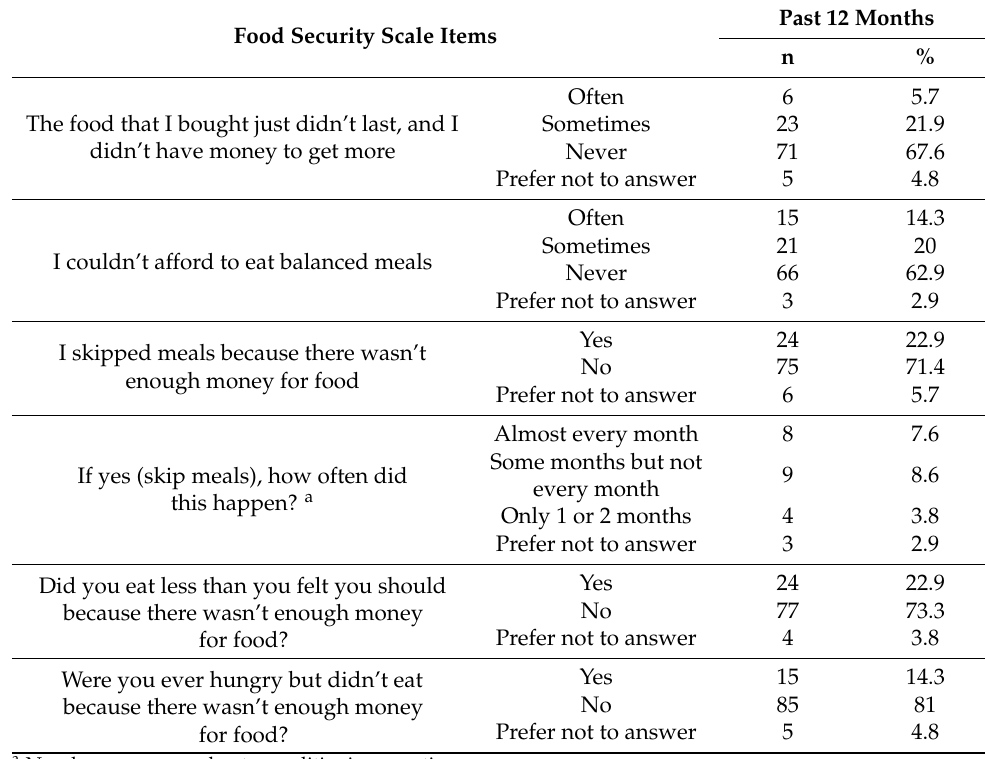
Table 3. Twelve-month prevalence of food insecurity indicators (N =